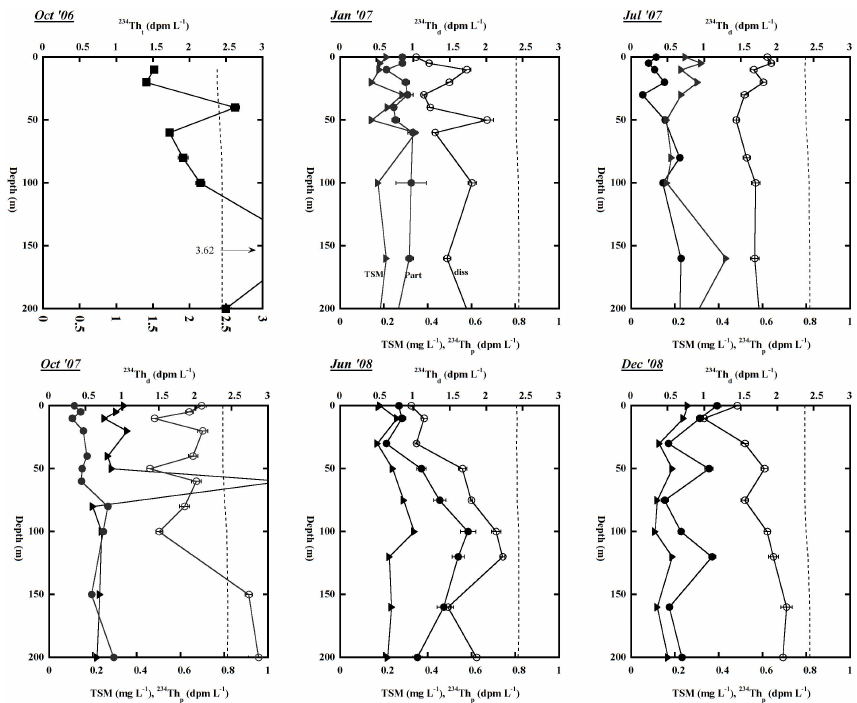
Fig. 2. Vertical distributions of dissolved (open circle) and particulate (solid circle) 234 Th, TSM concentration (solid triangle), and the 238 U (thick dotted line) calculated from salinity (Ku et al., 1977). Note only total 234 Th (solid square) is available for ORI-821 (October 2006). Error bars represent uncertainty based on propagated counting errors ( ± 1 σ ).